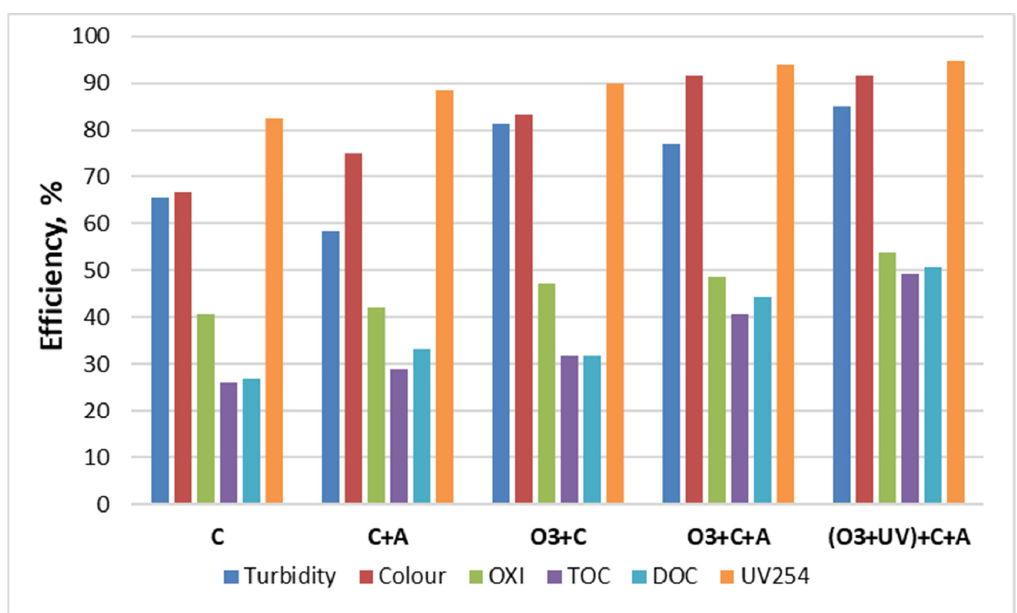
Figure 4. Efficiency of selected parameters removal from modified surface water treated in the coagulation process and hybrid processes; C—coagulation; C + A—coagulation + adsorption; O 3 + C—ozonation + coagulation; O 3 + C + A—ozona-